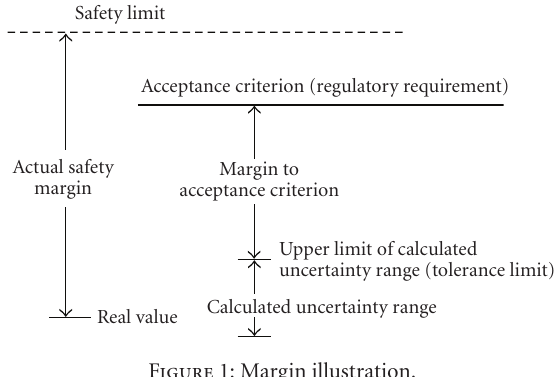
Figure 1: Margin illustration.